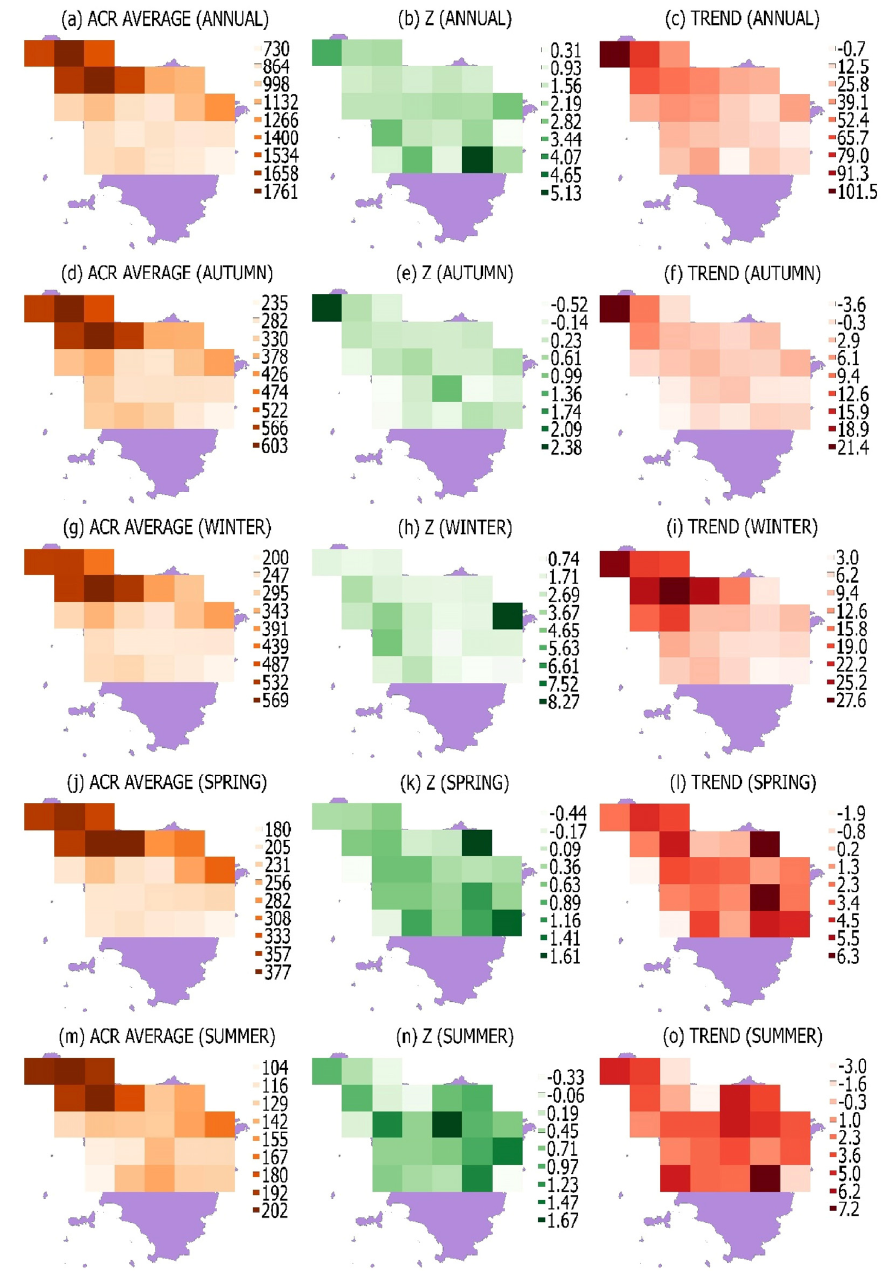
Figure 6. Annual and seasonal ACR_AV estimates ( a , d , g , j , m ); values of Z statistic ( b , e , h , k , n ); and magnitudes of the trend ( c , f , i , l , o) .